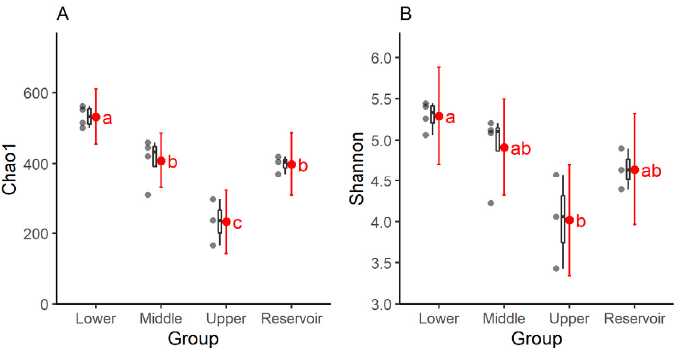
Figure 3. Bacterial ( A ) Chao1 and ( B ) Shannon values of the lower, middle, and upper reaches of the Nandu River and the Songtao Reservoir. Means not sharing any lowercase letter indicating significant differences among different groups.